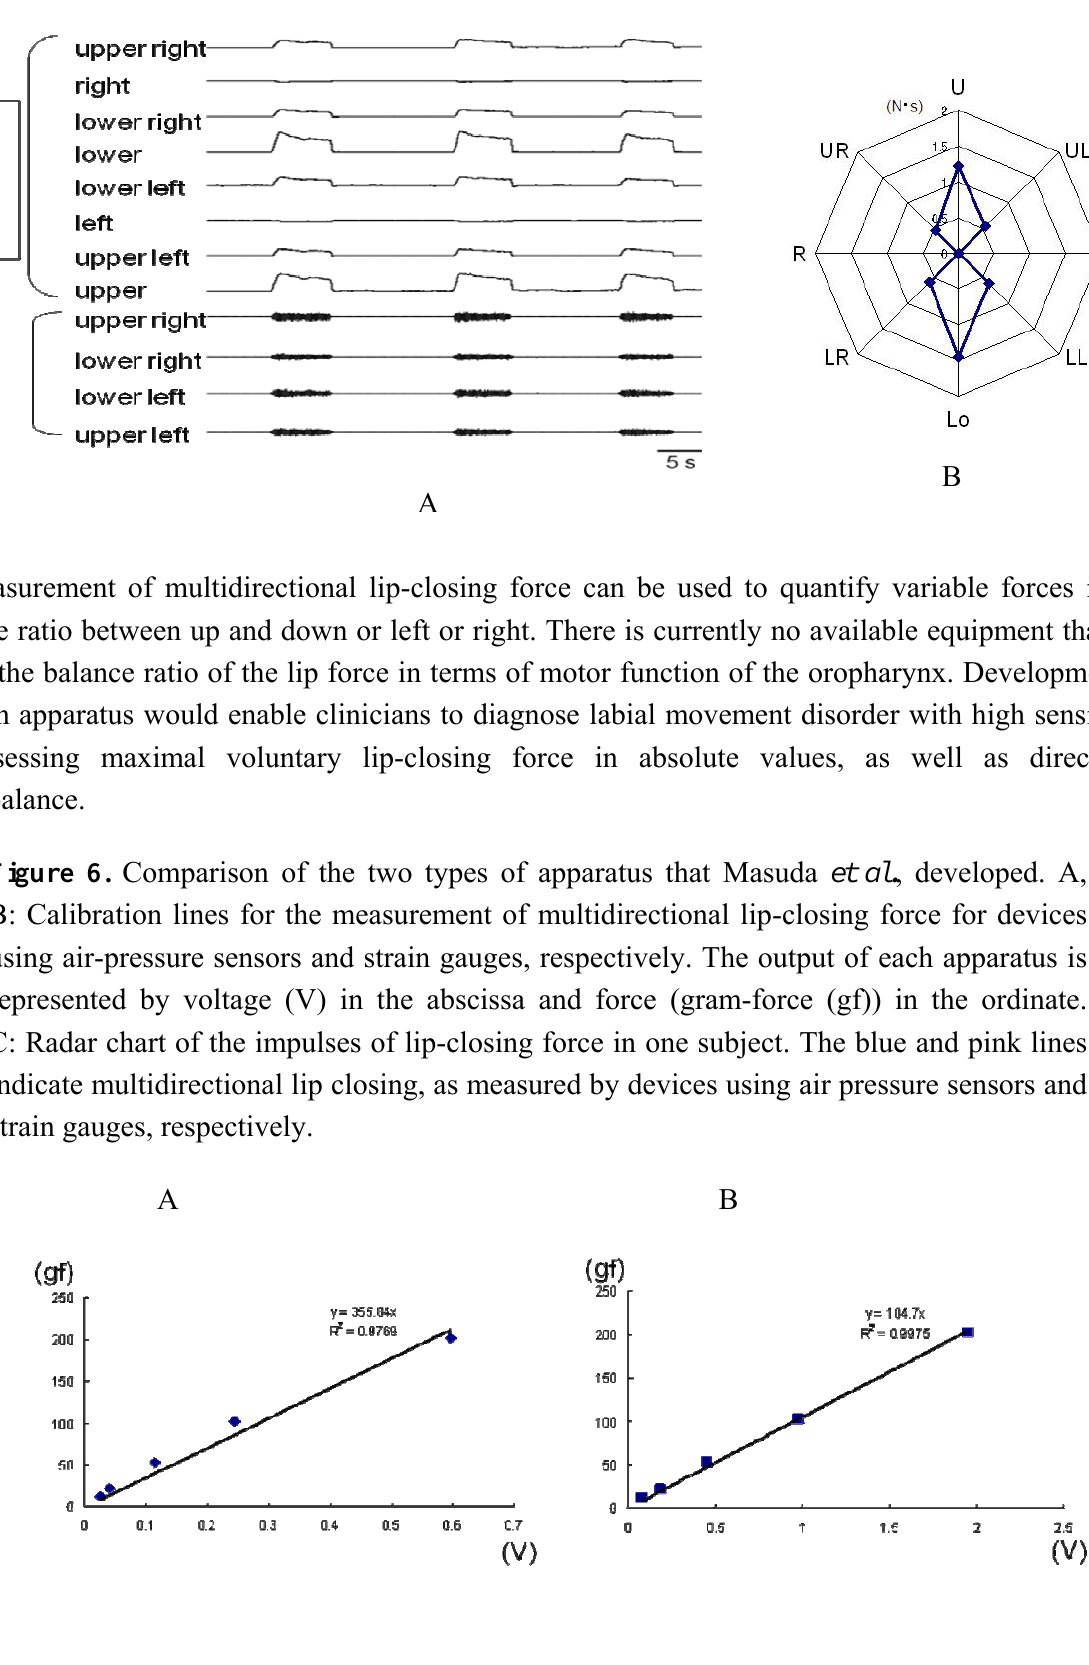
Figure 5. Example of the recording of multidirectional lip-closing force. A: lip-closing force in 8 directions and EMGs recorded from four lip muscle regions during maximal lip closing. B: radar chart showing the impulses of lip-closing force. The magnitude of the force differs among the eight directions.